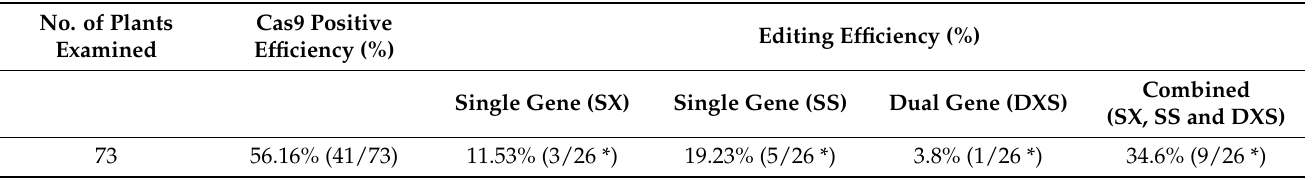
Table 1. Summary of Cas9 positive and editing efficiency in GE 0 lines of S. lycopersicum cv.